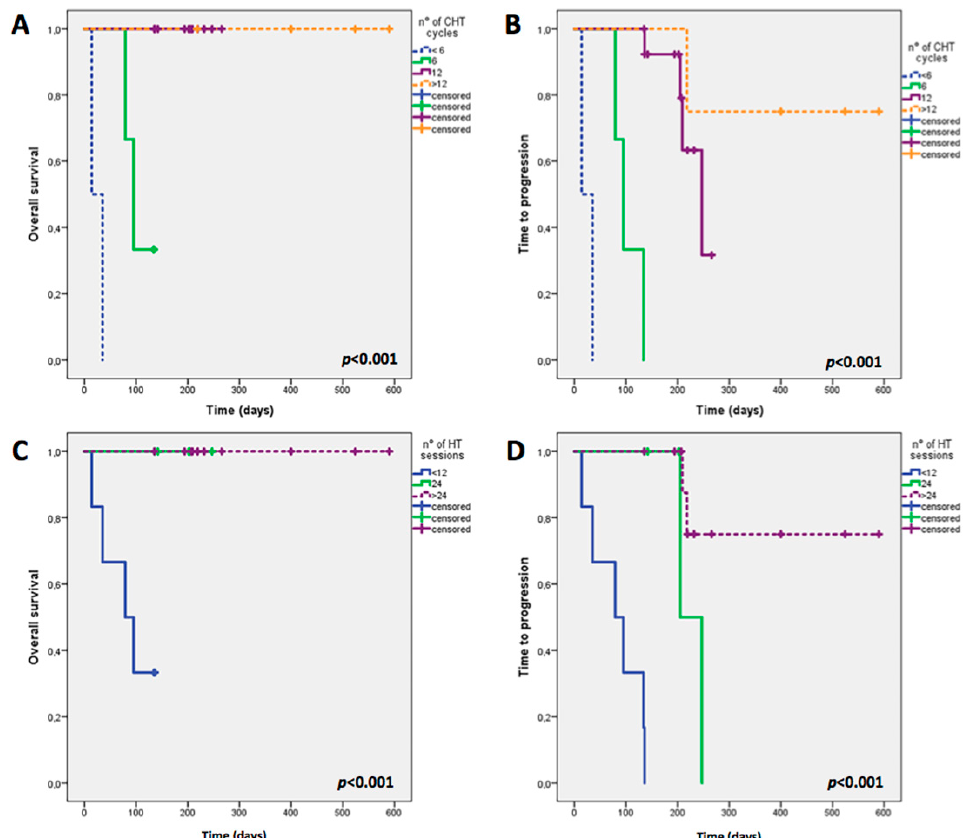
Figure 6. Overall Survival (OS) and Time to Progression (TTP) in relation to number of chemotherapy cycles (<6, 6, 12, >12) ( A , B ) and number of hyperthermia sessions (<12, 12, 24, >24) ( C , D ). CHT, chemotherapy; HT, hyperthermia. Both OS and TTP were influenced by the number of chemotherapy cycles (Log Rank = 35.406, p < 0.001; Log Rank = 43.995, p < 0.001) and HT sessions performed (Log Rank = 15.470, p < 0.001; Log Rank = 32.479, p < 0.001) ( A – D ).